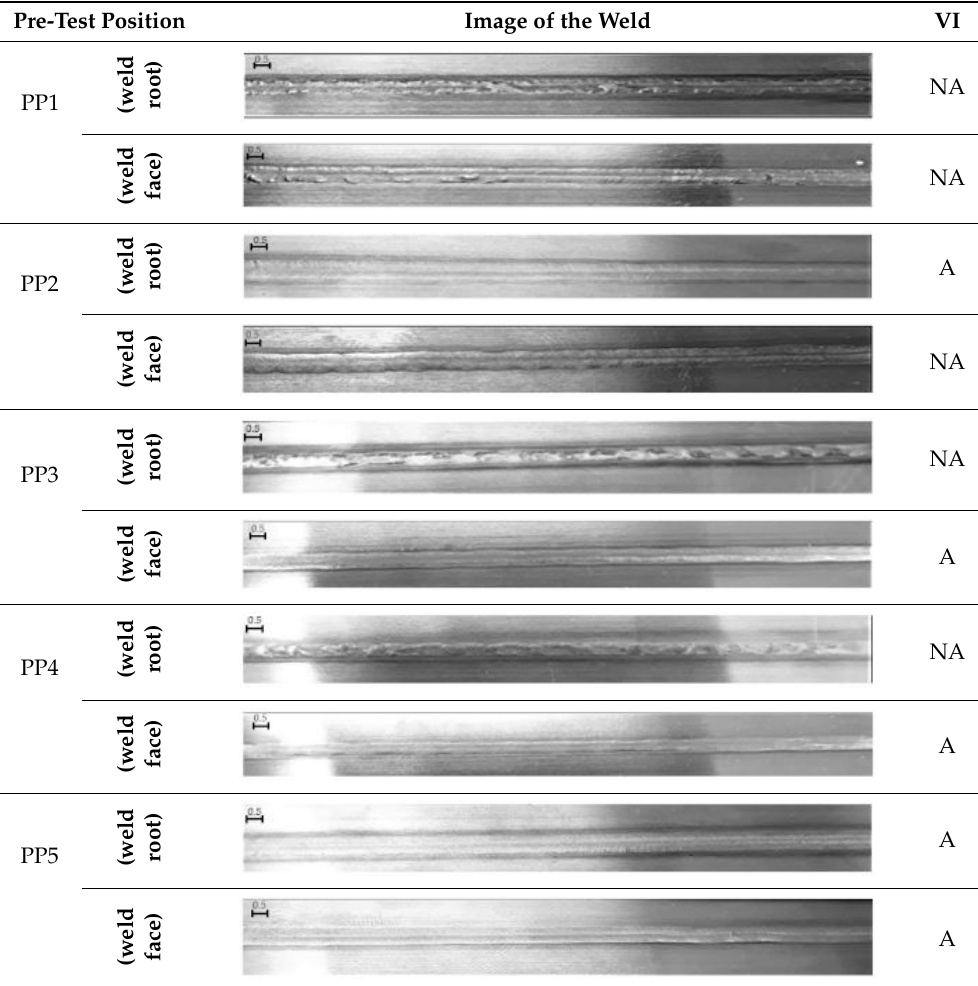
Figure 2. Setting the welding parameters on the automatic welding machine. Table 3 contains information about the visual inspection of welded joints (acceptable welded joints—A, not acceptable welded joints—NA). Table 3. Visual inspection (VI) of welded